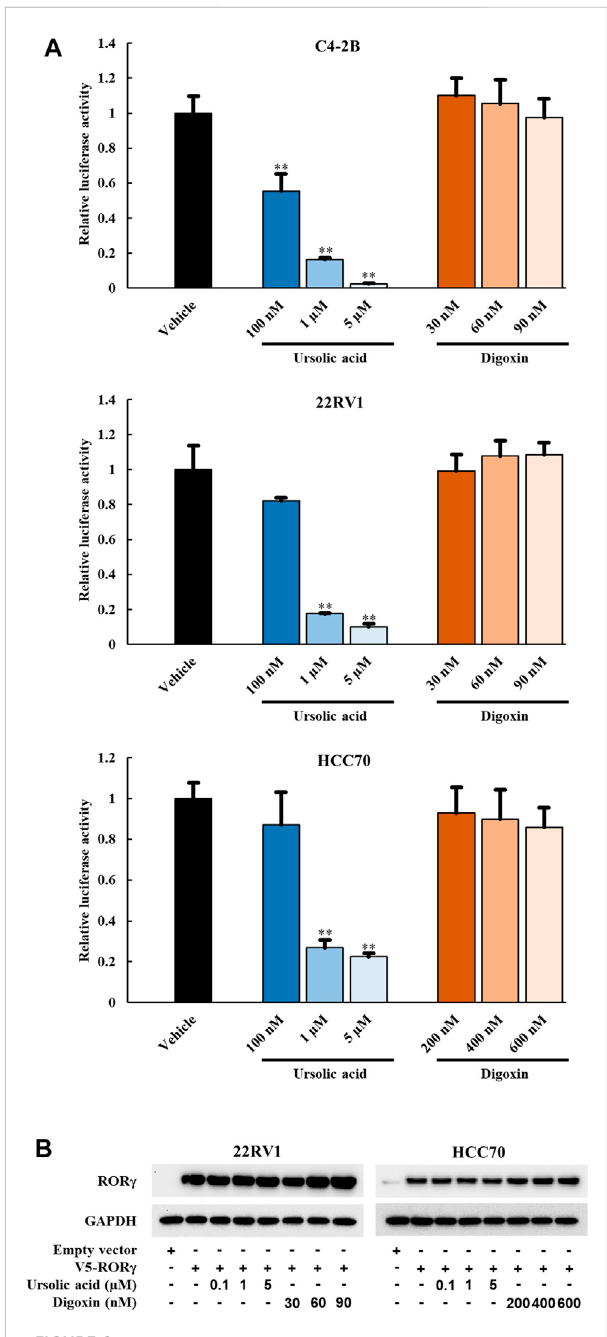
FIGURE 2 UA but not digoxin blocks transactivation function of ROR γ in PCa and TNBC cells. (A) 7X-RORE luciferase reporter activity changes by treatment of ursolic acid or digoxin in C4-2B (top), 22RV1 (middle) or HCC70 (bottom) cells for 24 h. Normalized luciferase activity from cells treated with vehicle and transfected with ROR γ -expressing plasmid were set as 1. Data are shown as mean ± SD. n ≥ 3. Student ’ s t-test. ** p < 0.01. (B) . Immunoblotting of 22RV1 and HCC70 cells transfected with V5-RORC expression vector. Twelve hours after transfection, cells were treated with UA or digoxin at indicated concentration for another 24